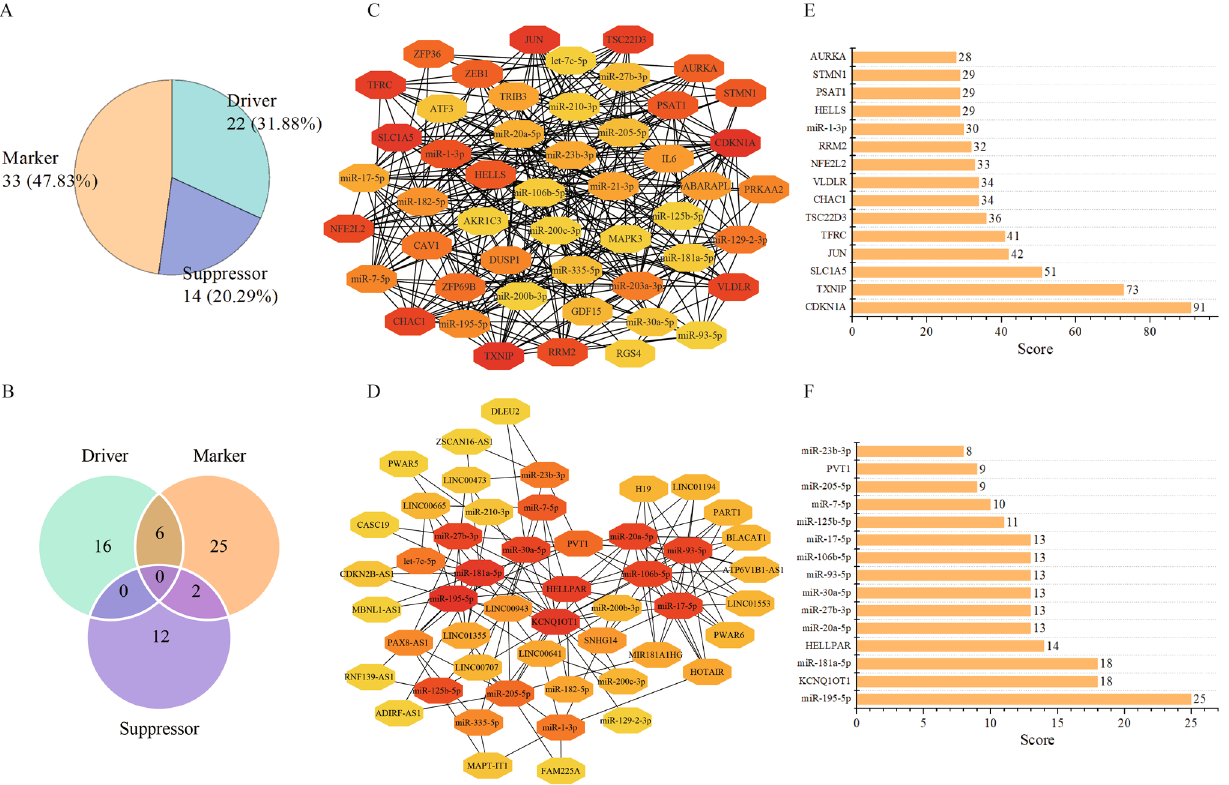
Figure 3. ( A ) Classification of differentially expressed genes associated with ferroptosis in gastric cancer. ( B ) Intersection of driver genes, suppressor genes, and marker genes. ( C ) The hub subnetwork between the 242 DEmiRNAs and 57 ferroptosis-related genes. ( D ) The hub subnetwork between the 20 DEmiRNAs and 83 DElncRNAs. The color of the point represents the connectivity of the node in the network. The darker the color of the nodes, the more important the genes in the network. ( E ) The top 15 key DEmiRNAs/ferroptosis-related genes in the interaction network between the 242 DEmiRNAs and 57 ferroptosis-related genes. ( F ) The top 15